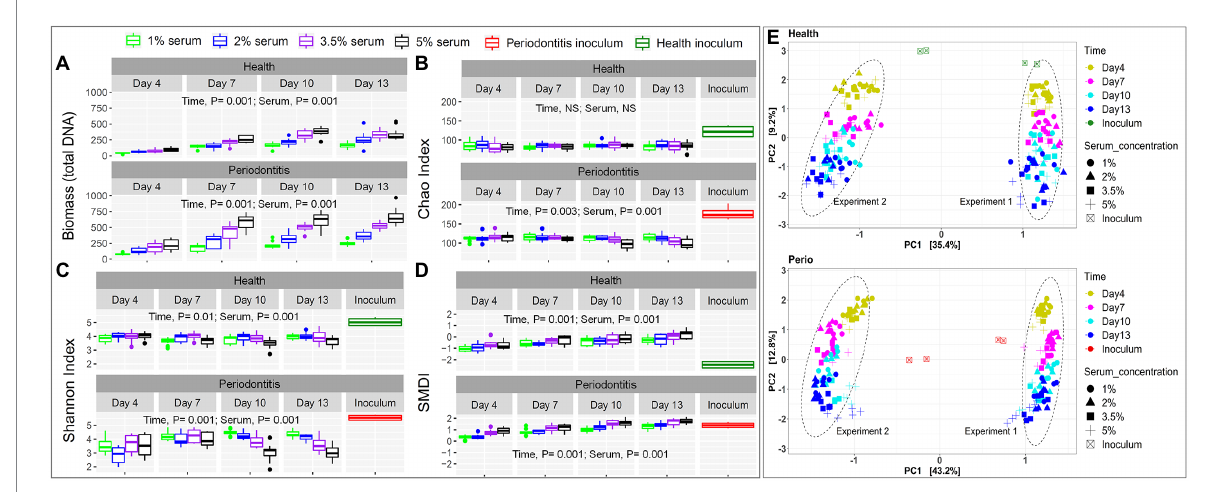
FIGURE 4 In vitro microbiome diversity as a function of serum concentration and incubation period. Biomass (A) , Chao Index (B) , Shannon Index (C) , and subgingival microbial dysbiosis index (SMDI, D ) are presented as boxplots by serum concentration and time point for the health- and periodontitis- derived microbiomes separately. Statistical comparisons were performed using generalized linear models (multinomial distribution) with biological replicate, medium, shaking and time as covariates. (E) Principal component analysis (PCA) plots based on centered log-ratio (CLR) transformed data by serum concentration, time point and experimental replicate. Plots were produced with R.